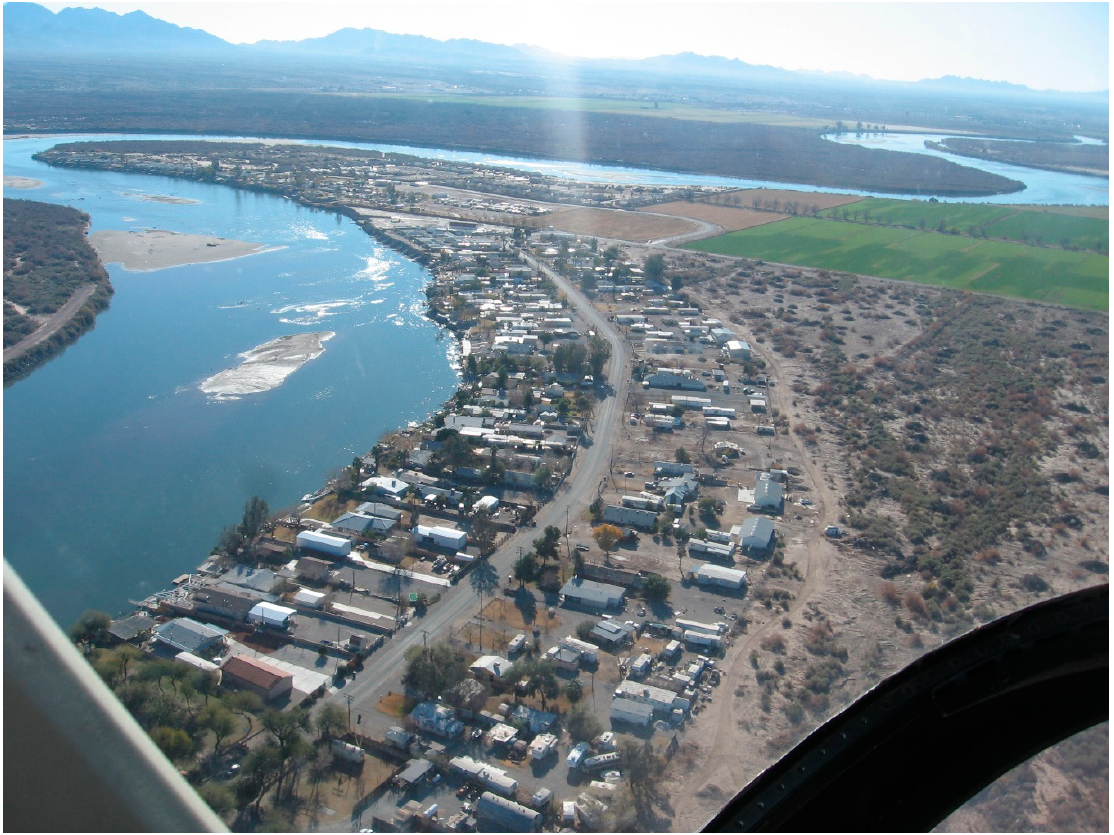
Figure 1. The Colorado River near Yuma, AZ provides an example of meander bends (photograph taken 4 January 2007).